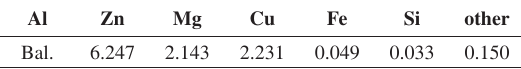
Table 1. Chemical composition for AA7050 alloy